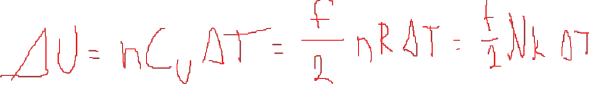
FIG. 8. Fredrik copies the formula, but without engaging with the semiotic